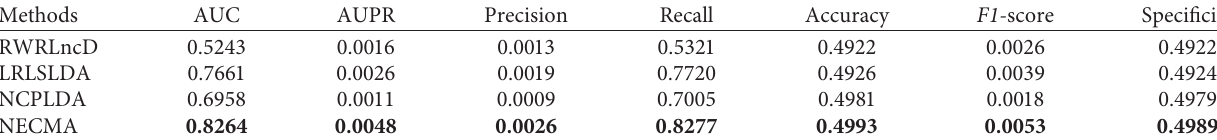
Table 1: Performance comparison of NECMA with RWRLncD, LRLSLDA, and NCPLDA.